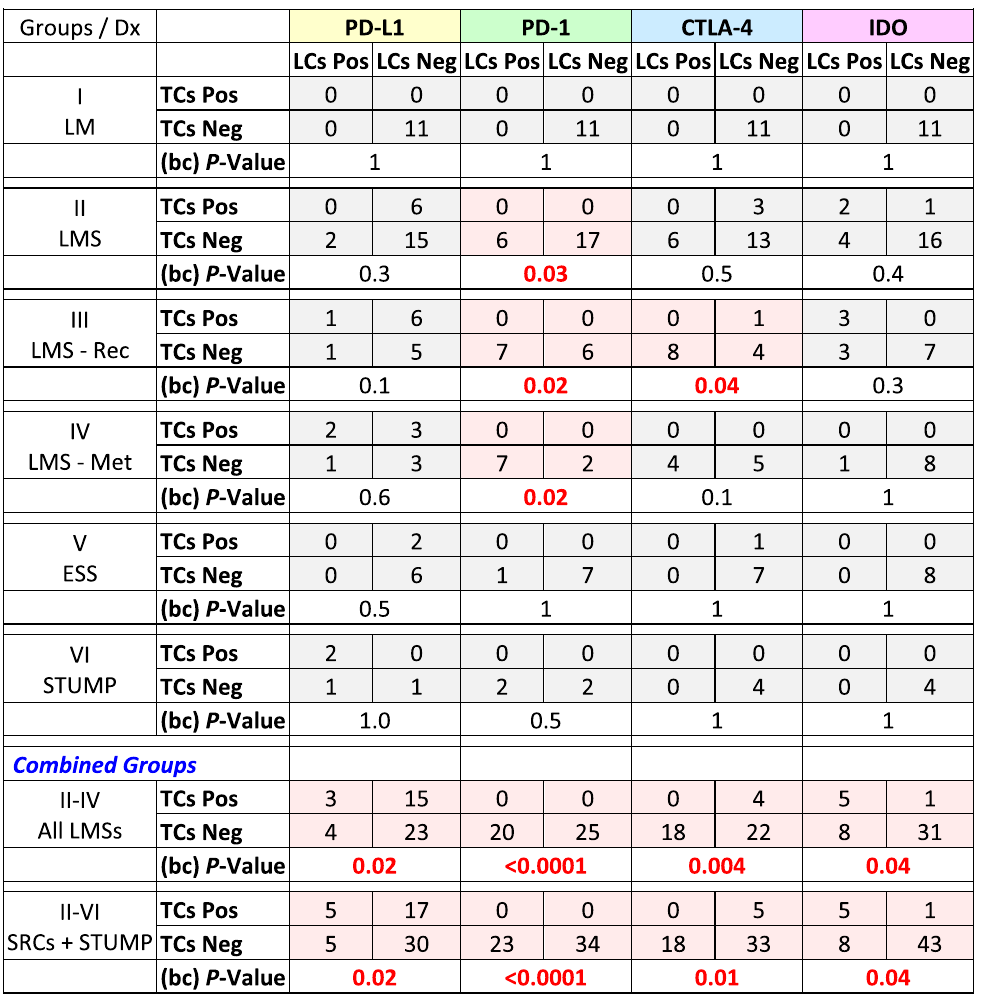
Table 4 2 2 Tables of McNemar’s chi-square tests for matched-pairs tumor cells versus infiltrating lymphoid cells × immunohistochemistry reactions, to compare